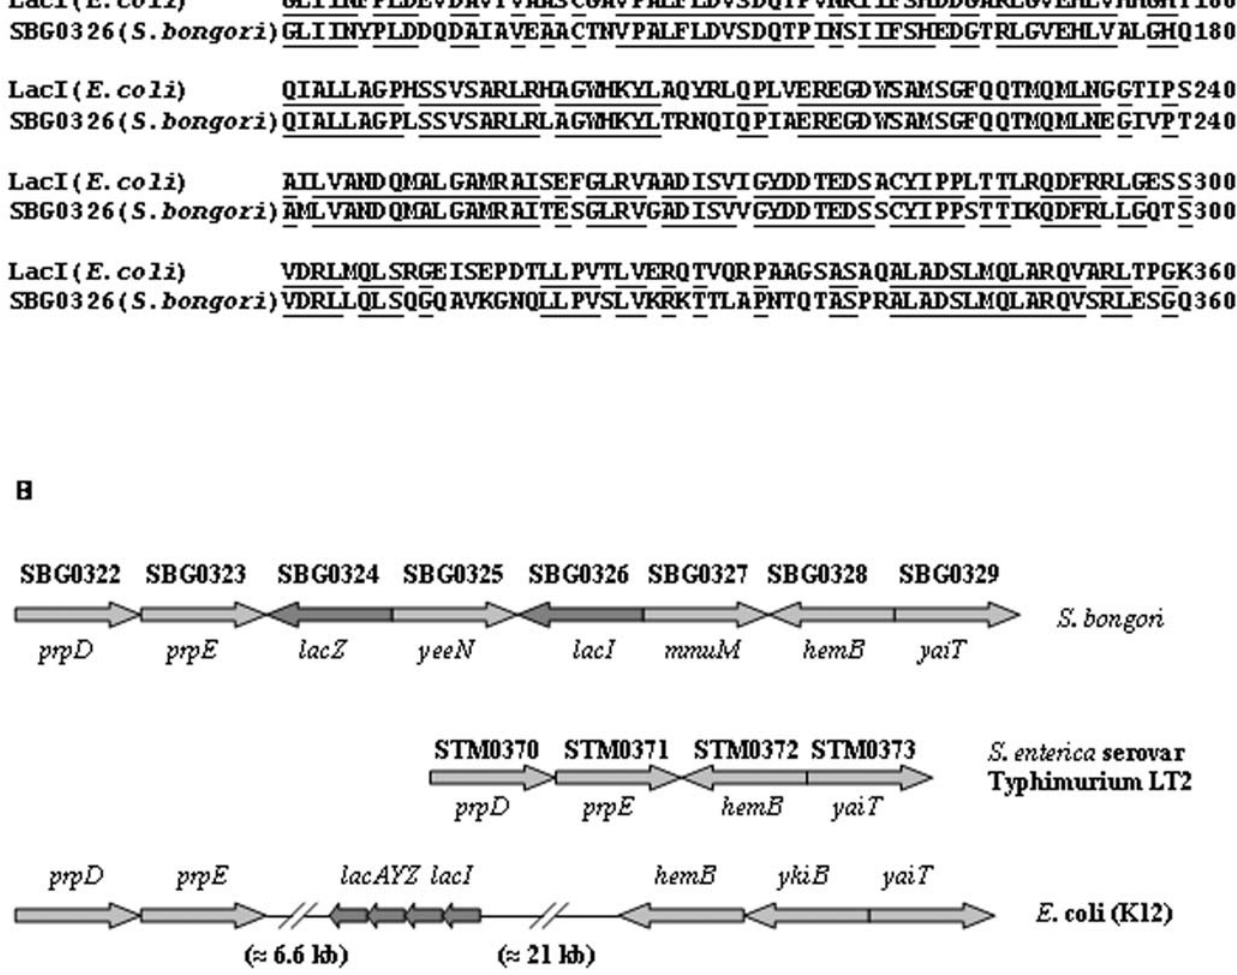
Figure 7. SBG0326 of S . bongori is homologous to lacI of E . coli . (A) Alignment of predicted amino acid sequences of SBG0326 and LacI ( E . coli K12). Both of them share 77% identity and 88% similarity. Identical residues are underlined. (C) Schematic diagram showing organization of prpE to hemB locus in S . bongori , S . Typhimurium and E . coli (K12). Each arrow represents indicated gene. Genes belonging to lac region are shown in darker shade. In case of S . bongori and S . Typhimurium, the names of the homologous genes in E. coli are given below the arrows. Arrows are not to scale.